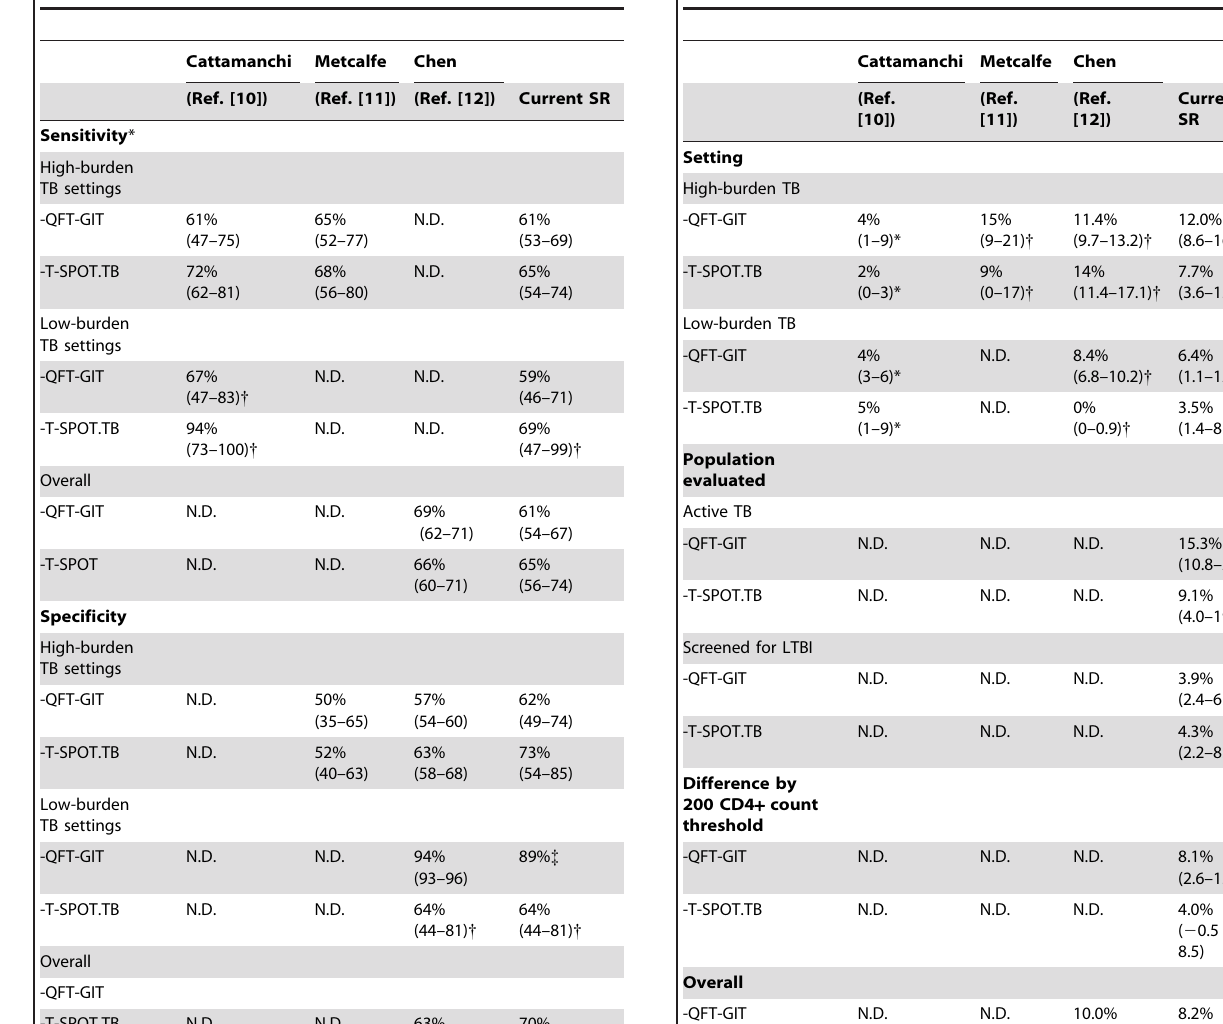
Table 8. Proportion of indeterminate results of IGRAs in HIV- infected patients in four systematic